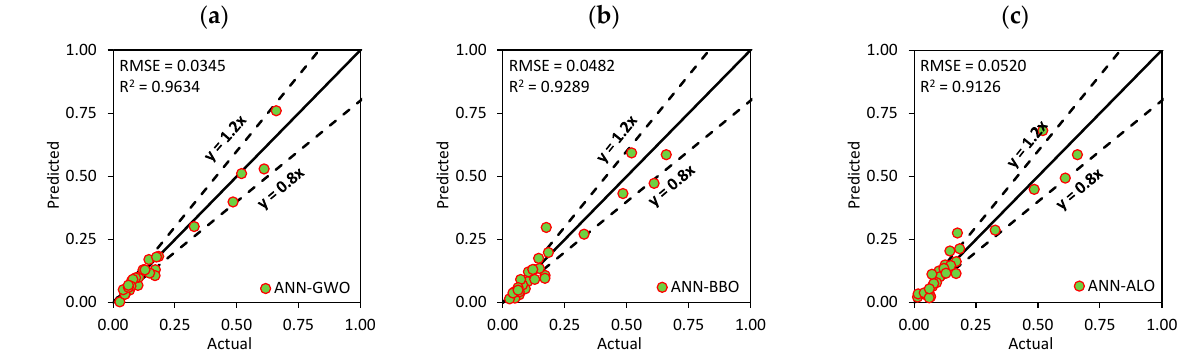
Figure 9. Scatter plots between the actual and predicted values for the best three models: ( a – c ) training and ( d – f ) validation datasets. The performance of ANN-PSO significantly improved in the testing phase compared Table 7. Model performance in the testing phase. to the training phase with the value of R 2 = 0.9274. In the training and testing phases, the RMSE values of the created models varied from 0.0291 to 0.0898 and 0.0345 to 0.1243, respectively. These results suggest that the generated models had a smaller error range, thereby, indicating a better level of accuracy. Figure 10 represents the scatter plots between the actual and predicted values for best three models (ANN-GWO, ANN-BBO and ANN- ALO) in the training phase.